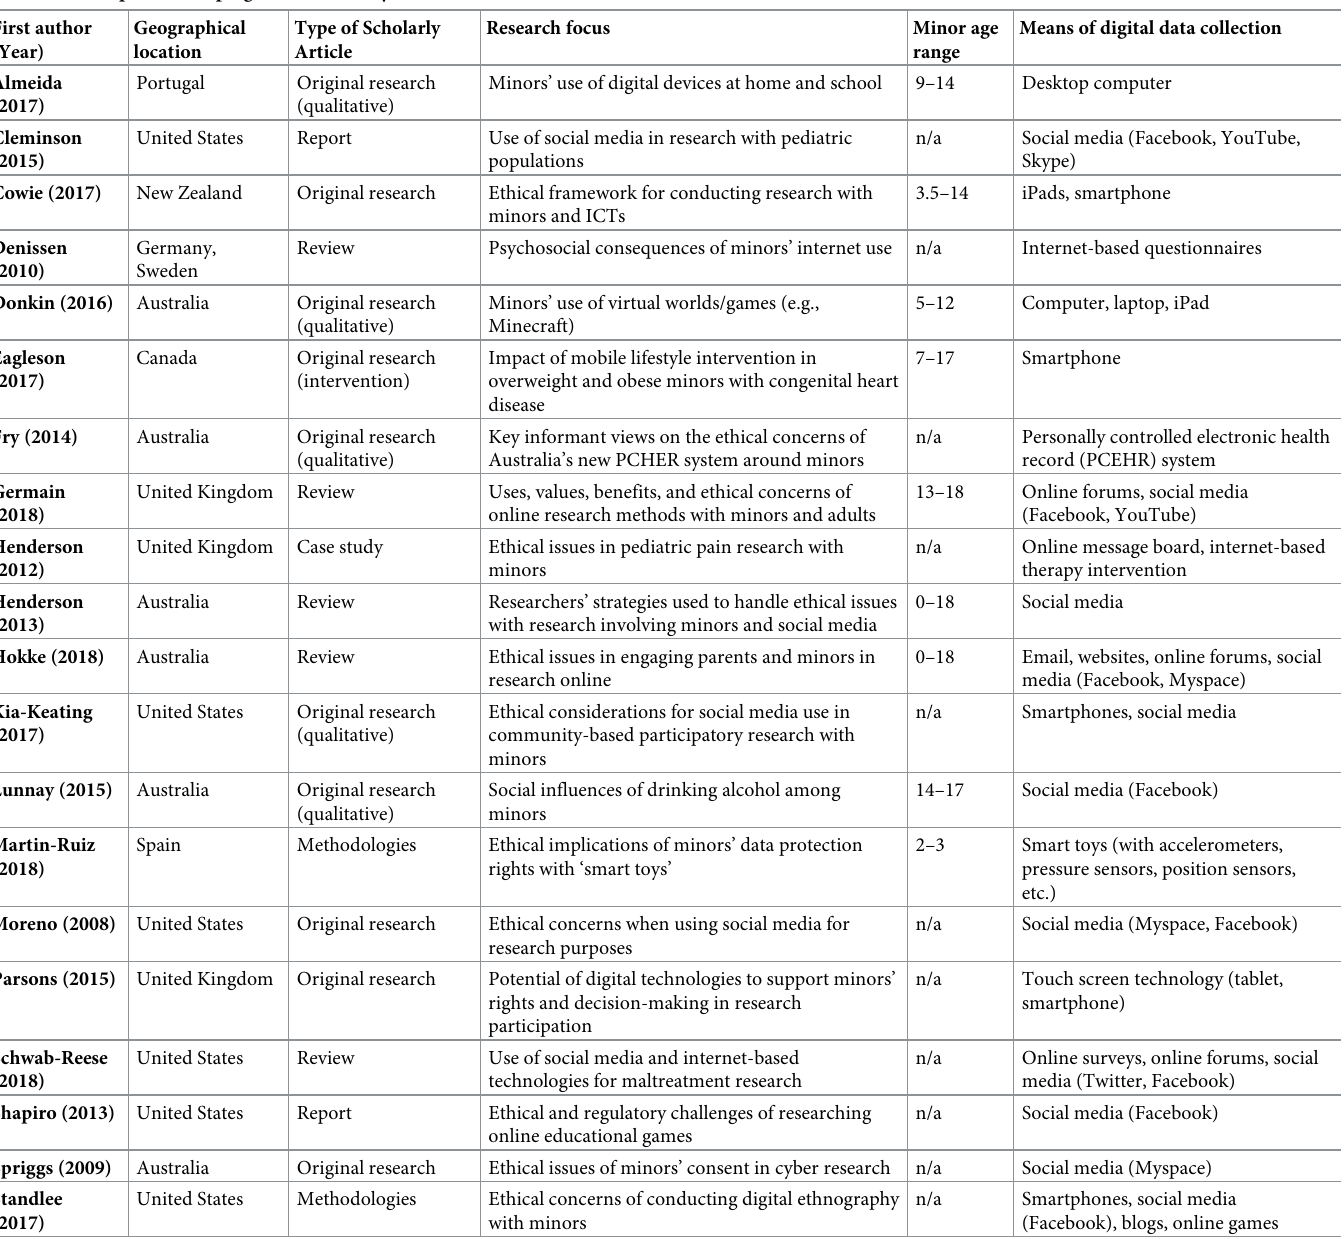
Table 2. Description of scoping review scholarly